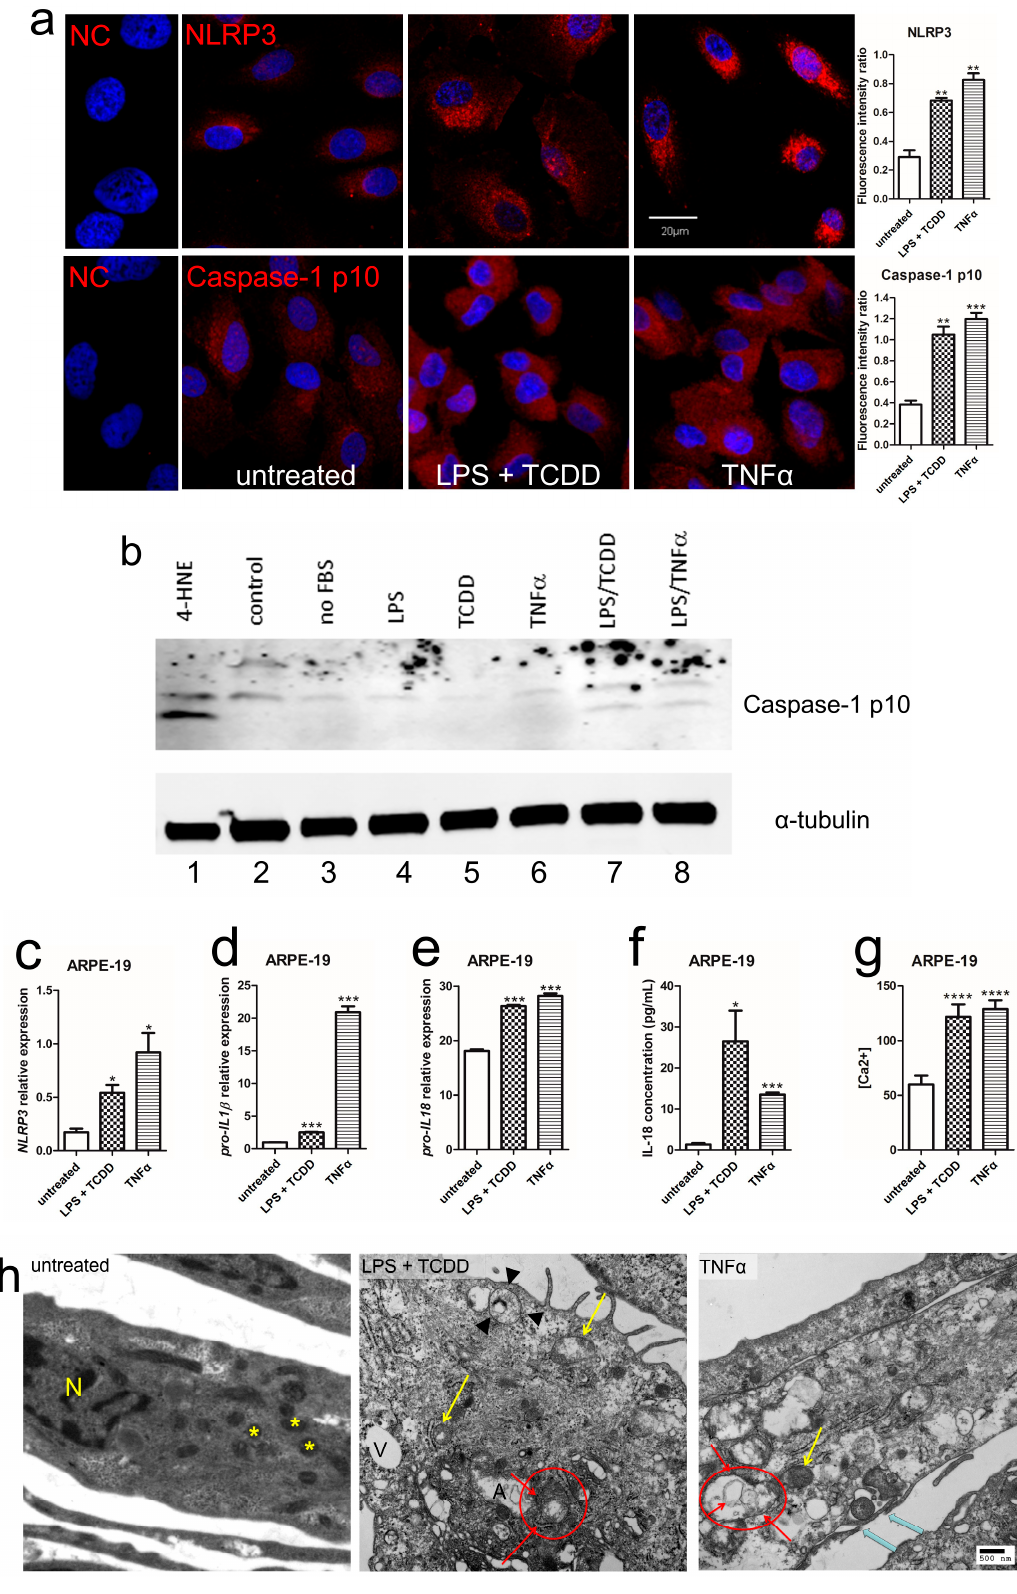
Figure 2. Cont. Figure 2.